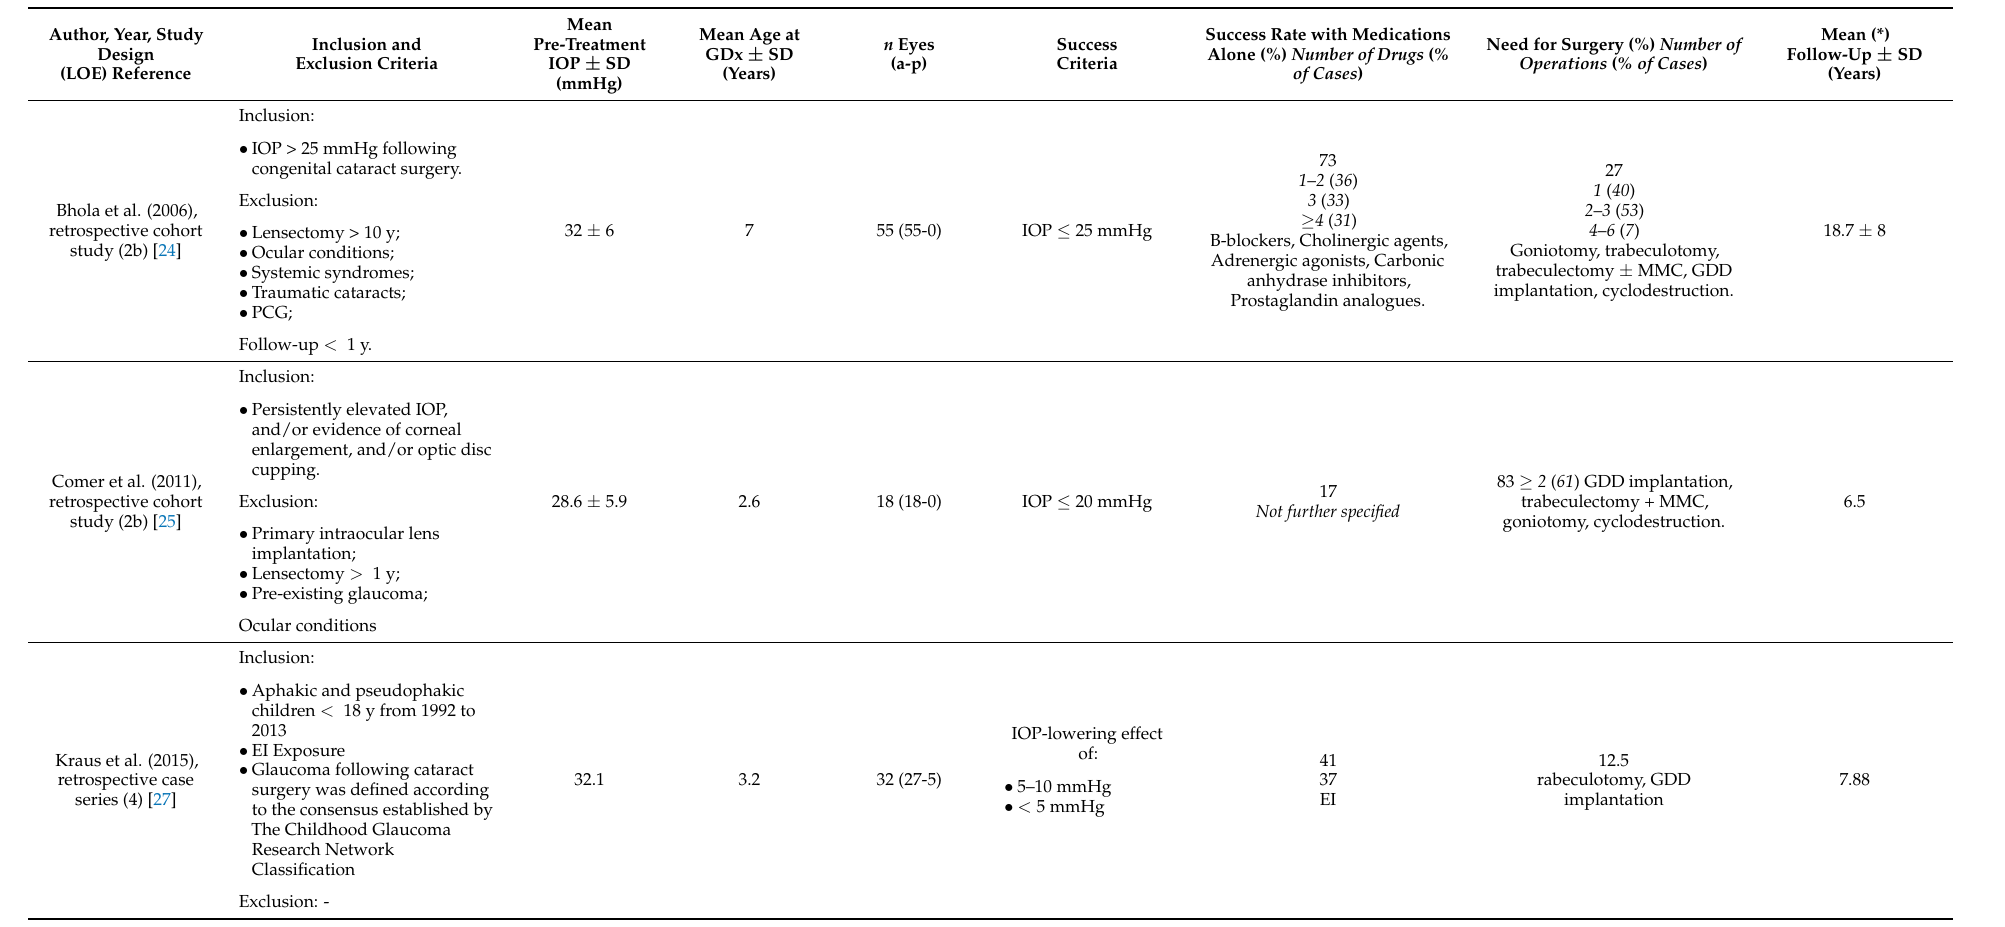
Table 1. Relevant studies involving success rates with medications alone and the need for surgical treatment in GFCS